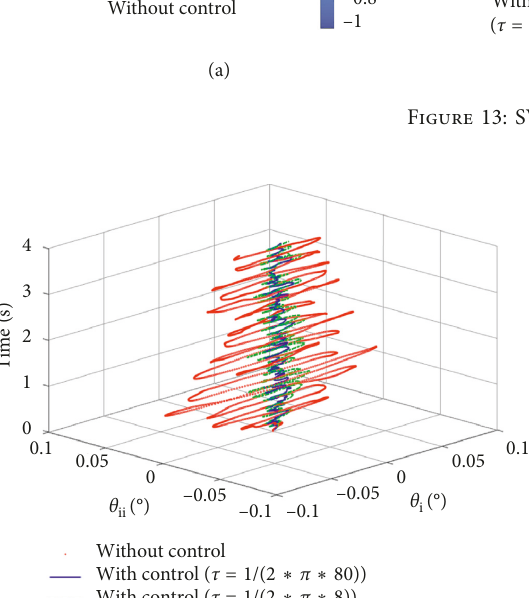
Without control